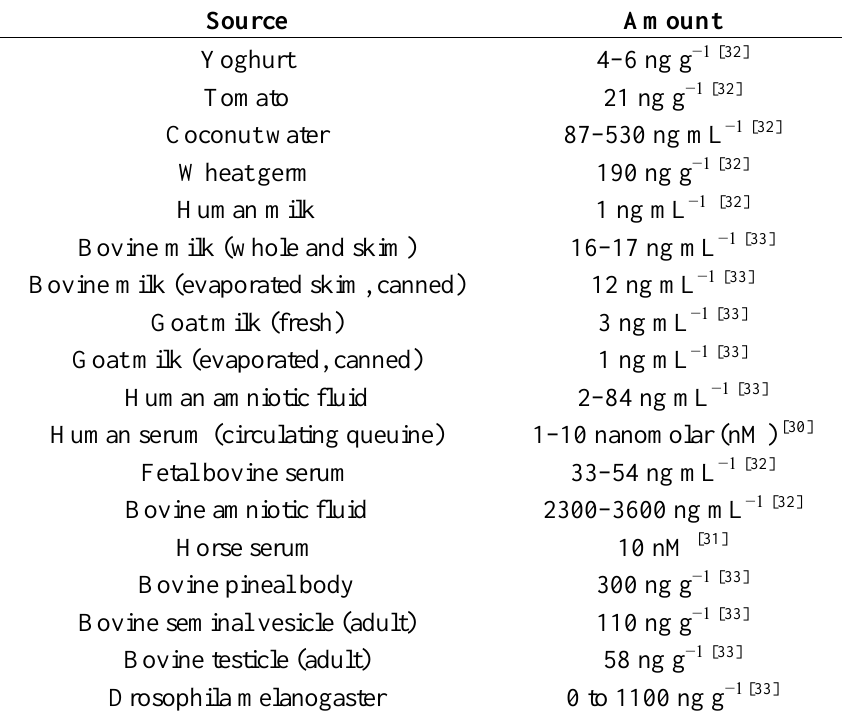
Table 1. Queuine levels in foodstuff and biological